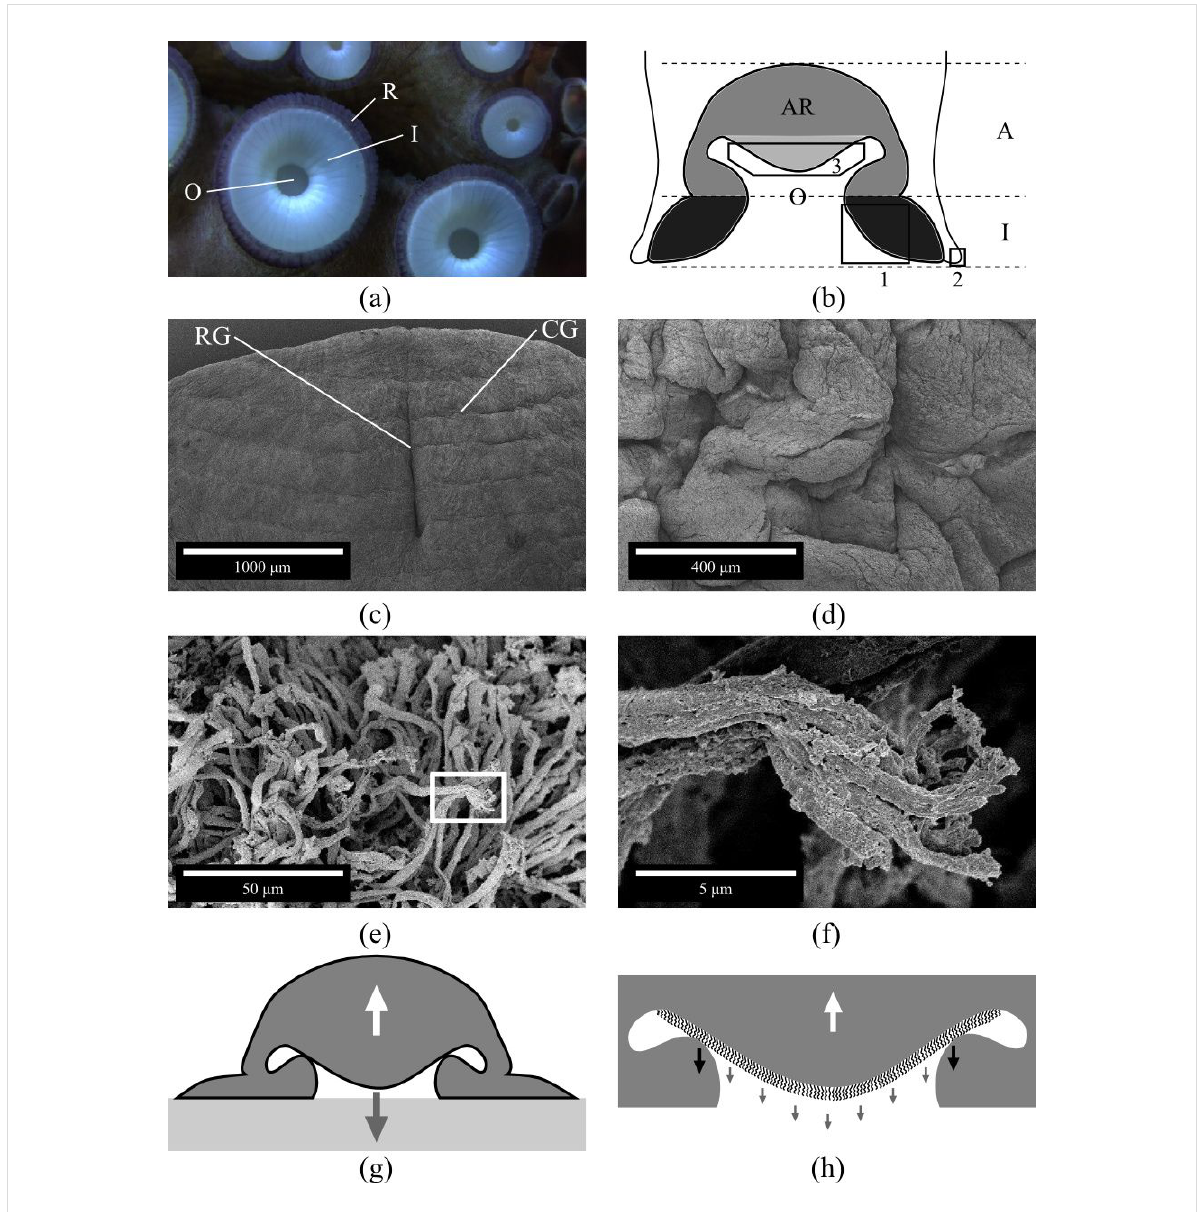
Figure 1: (a) Photograph of the frontal view of an octopus sucker. Infundibulum (I); orifice (O); and rim (R). (b) Schematic structure (transversal section) of an octopus sucker. The upper part in grey (light and dark grey) is the acetabulum (A). The lower disk-like black-coloured portion is the in- fundibulum (I). The light grey-coloured portion is the protuberance of the acetabular roof (AR); and O is the orifice. (c–f) Scanning electron microscopy images of an octopus sucker. (c) Infundibulum (please, refer to black box 1 in (b)). Radial (RG) and circumferential (CG) grooves. (d) Rim (please, refer to black box 2 in (b) and label R in (a)). (e) Surface of acetabular protuberance (please, refer to black box 3 in (b)). (f) Enlargement of white box in (e). (g) Sucker configuration during adhesion process [5]. The restoring elastic force (white arrow) is balanced by the cohesive forces of the water (grey arrow). (h) Enlargement of (g) considering the contribution of hairs. The restoring elastic force (white arrow) is counterbalanced by the cohesive forces of the water (grey arrows) and the adhesion force exerted by hairs (black arrows).